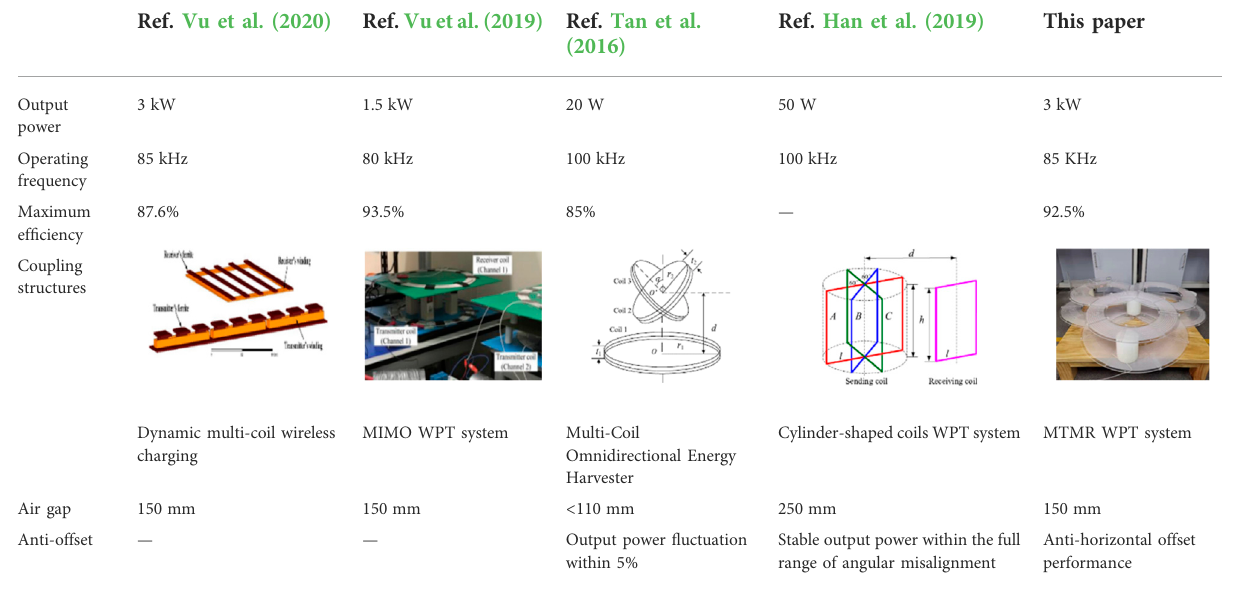
TABLE 3 Comparison of experimental results between the multi-coil WPT system in recent years from references and the system designed in this